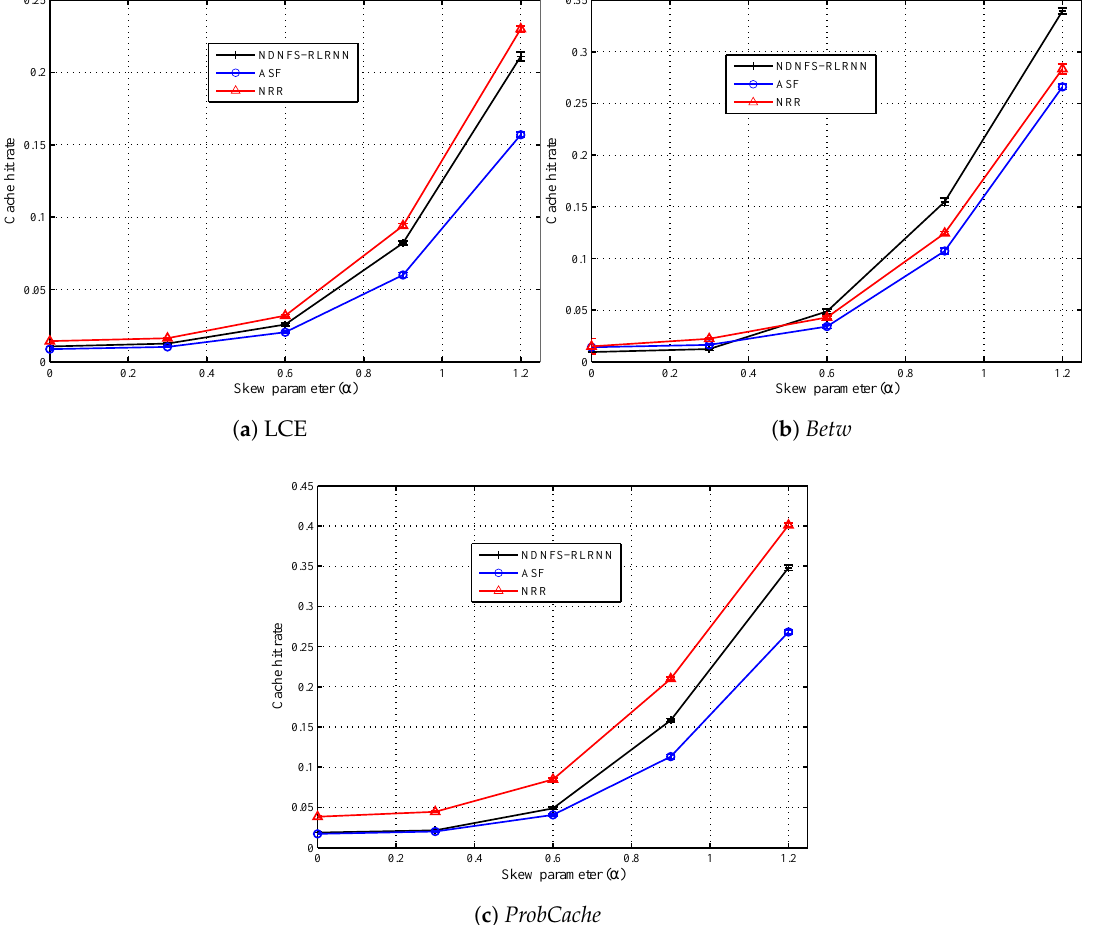
Figure 6. Cache hit rate performance of NDNFS-RLRNN ( p = 0.3), ASF and NRR for different uniform content popularity distributions, under: ( a ) LCE caching policy, ( b ) Betw caching policy